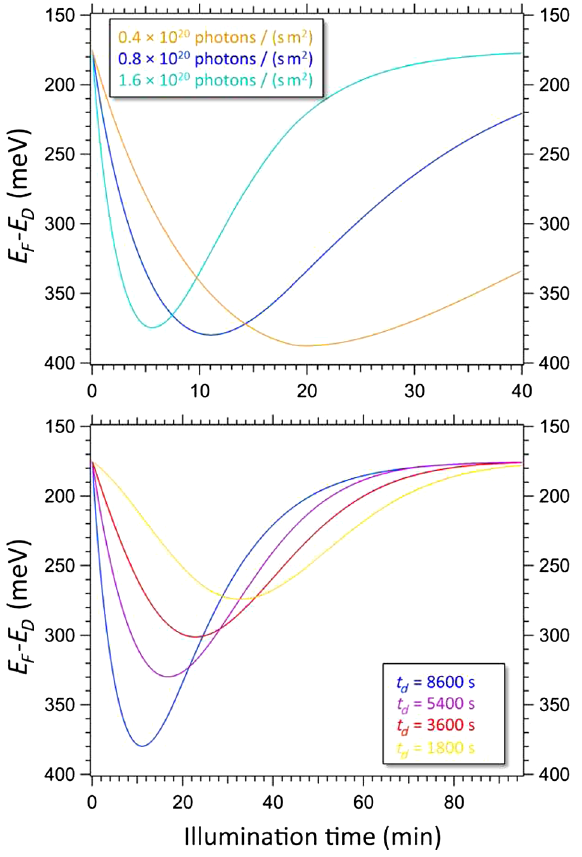
decoration on the surface band bending in 3D TIs. Top: Time- dependent energy value of the Fermi level with respect to the Dirac point for various values of the incoming photon flux. Bottom: Time-dependent energy value of the Fermi level with respect to the Dirac point for various time intervals of the surface decoration while the sample was still in the dark. All other parameters of the model are described in the text and they are identical to those used in Fig.